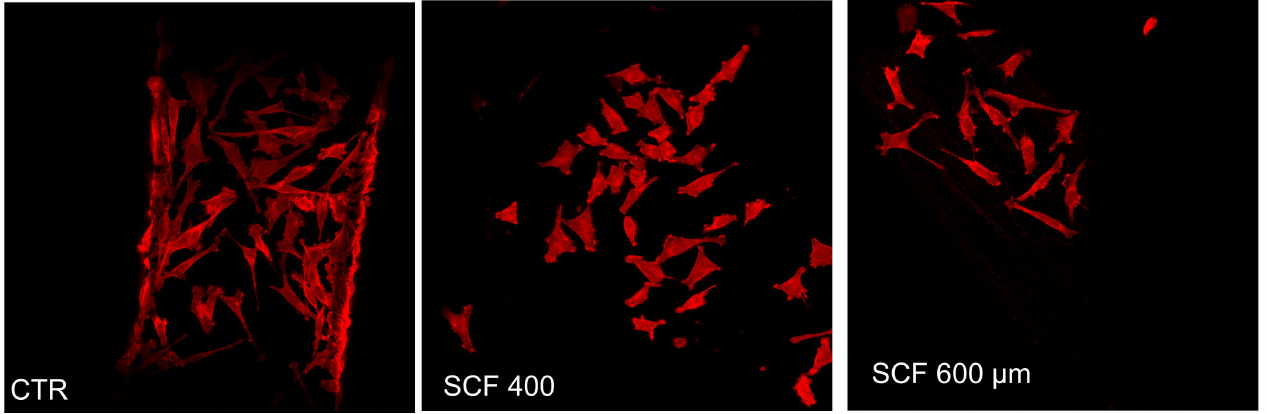
Figure 2. Actin distribution analysis of the SAOS-2 cells seeded on SCF 400 scaffolds, SCF 600 scaffolds, and PLA control (CTR) by confocal laser scanning